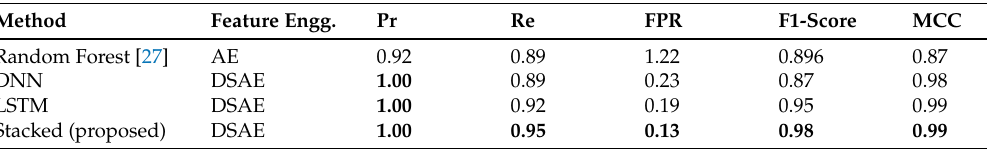
Table 11. Result of evaluation matrices w.r.t. existing approaches on the IoT-23 test set; best results are indicated with bold.